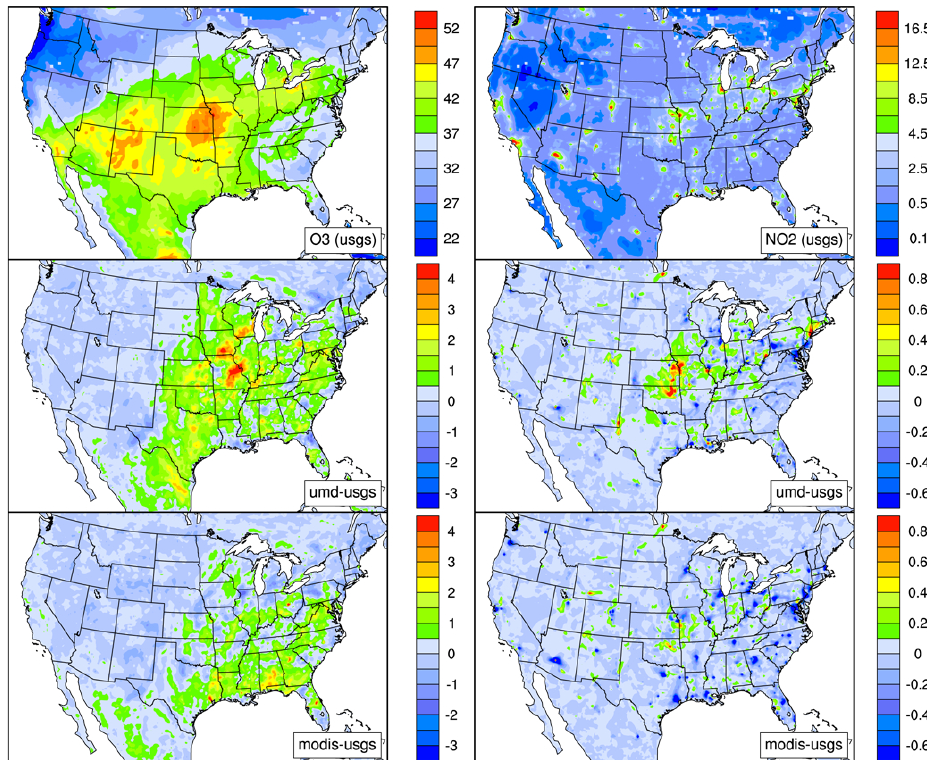
Fig. 8. Same as Fig. 3 except for average surface ozone concentration (ppbv, left panels) and NO 2 concentration (ppbv, right